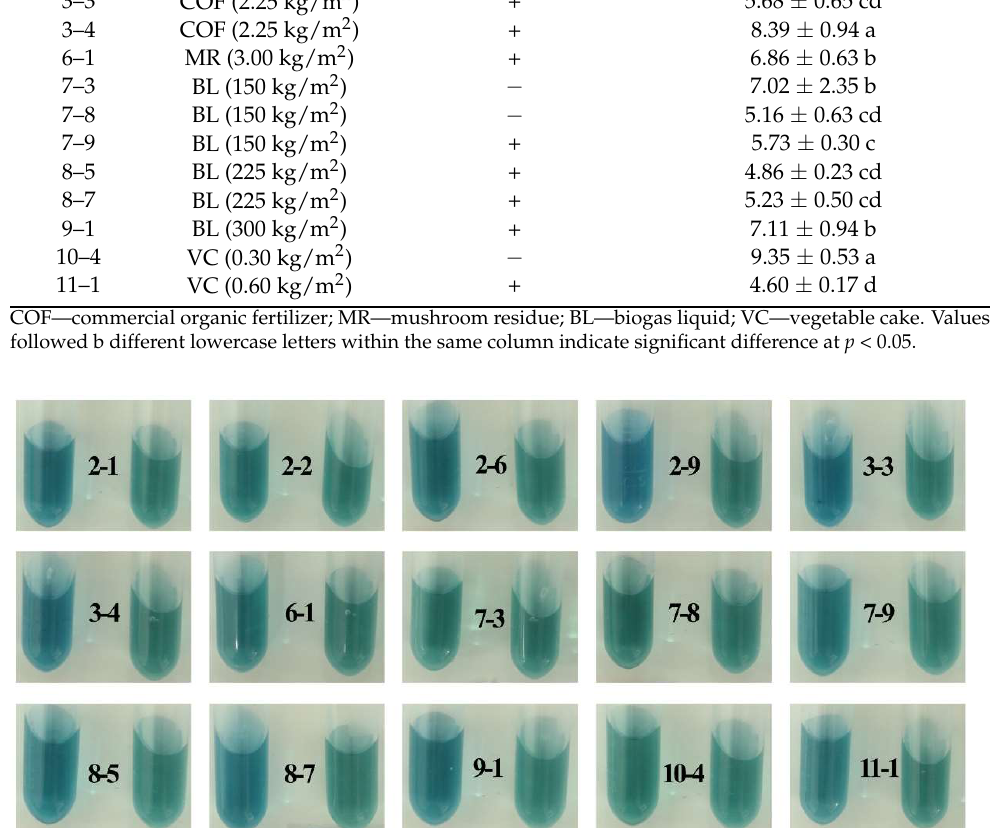
Table 8. Identification of representative isolates of P-solubilizing and N-fixation bacteria based on analysis of 16S rDNA sequence.